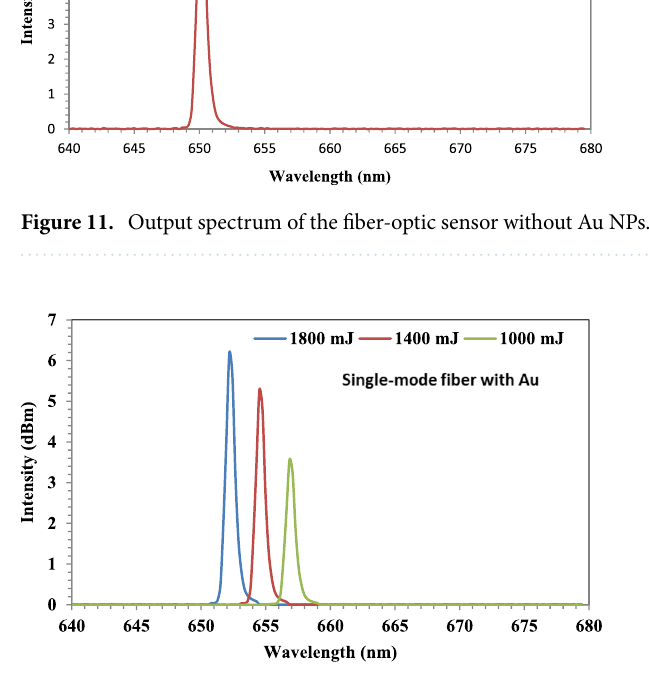
Figure 12. The output spectra of the fiber-optic with Au NPs at ablated energies of 1000, 1400, and 1800 mJ.